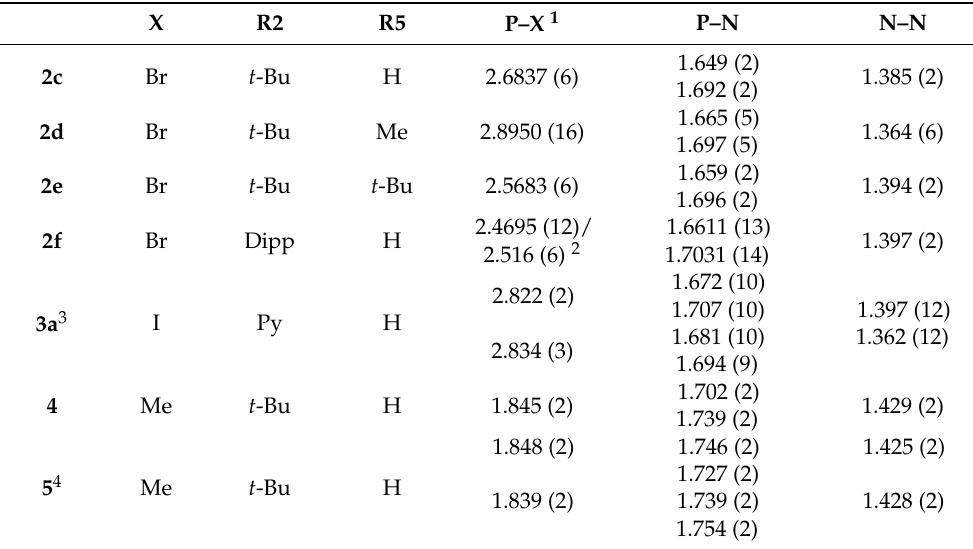
Figure 1. Representation of the molecular structures of 2e (left, with contacts to the phosphorus and bromine atoms of adjacent molecules) and a dimeric unit of 2d (right) in the crystal. Hydrogen atoms were omitted for clarity and intermolecular contacts were drawn as dashed lines. Thermal ellipsoids were drawn at the 50% probability level. Intermolecular distances (in Å ): P1 … Br1#1 3.6133 (16) ( 2d ), 3.8782(6) ( 2e ). Representations of the molecular structures of 2c , f , and 3a are included in the Supplementary Material, and selected distances for all compounds are listed in Tables 1 and S2. Table 1. Selected intramolecular distances (in Å) for 2c – f , 3a , 4 , 5